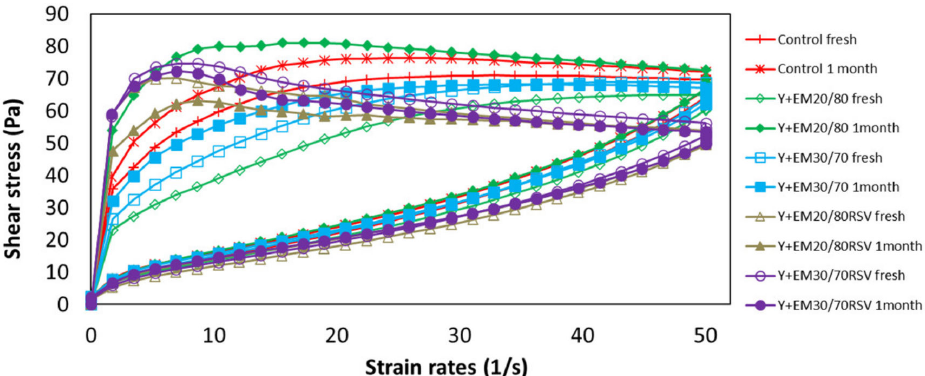
Figure 4. Upward and downward flow curves for both fresh yoghurts (with or without RSV) and those stored in the fridge for one month. The ten upper lines correspond to upward flow curves and the ten lower lines correspond to downward flow